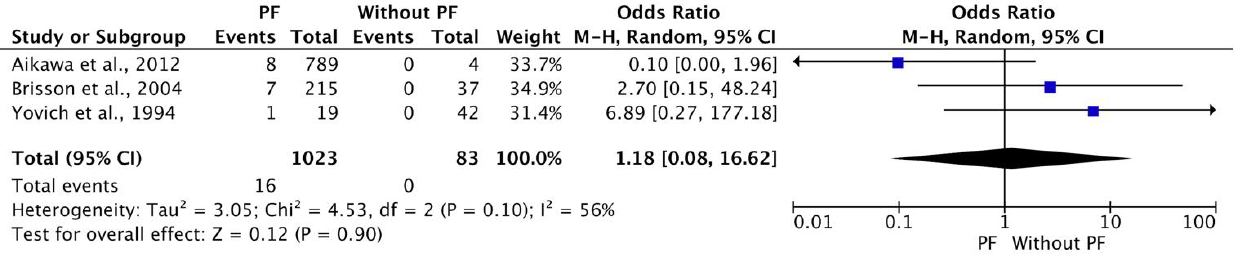
Figure 7. Meta-analysis for recurrence ratio on disc(s) adjacent to surgically treated area (with prophylactic fenestration; without prophylactic fenestration).